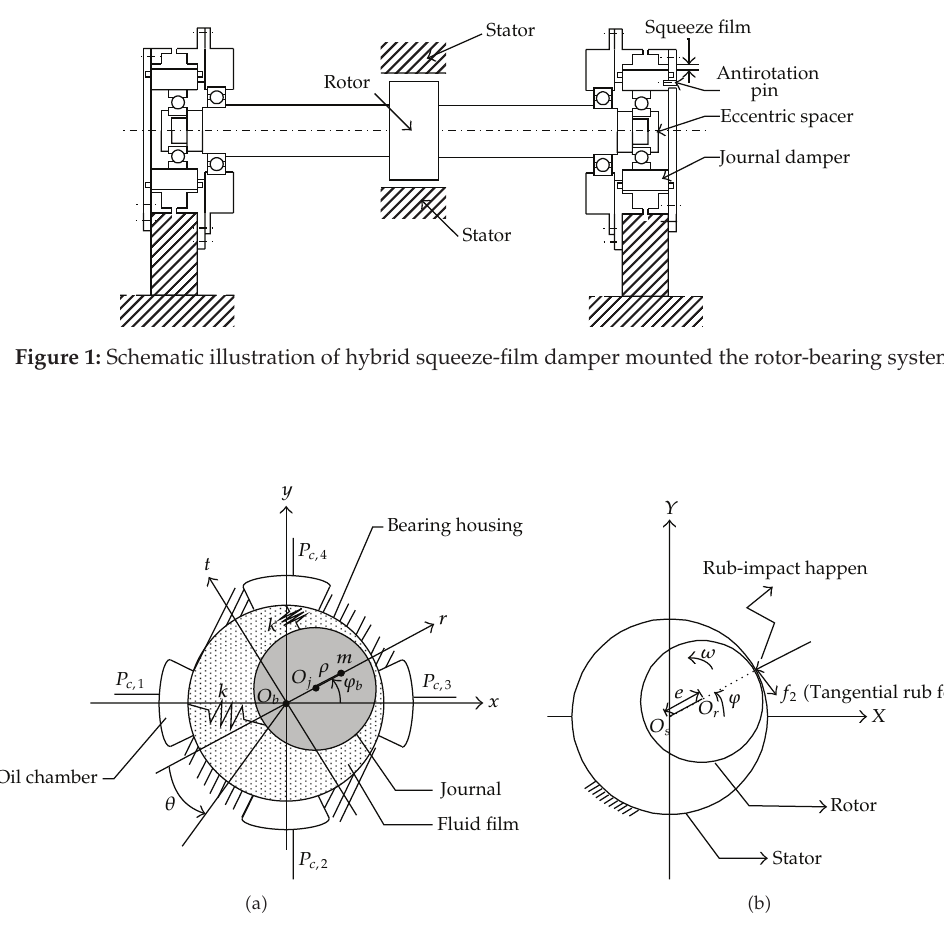
Figure 2: Cross-section of HSFD model and rub-impact rotor-stator